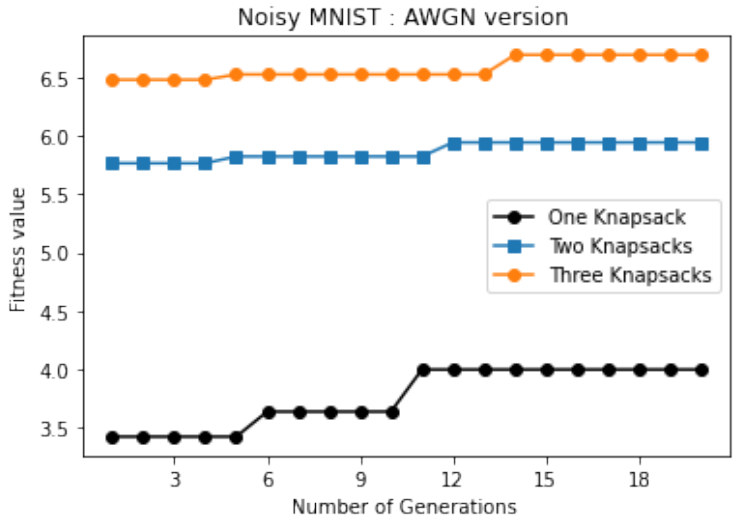
Figure 15. GA fitness vs. the number of generations for AWGN.